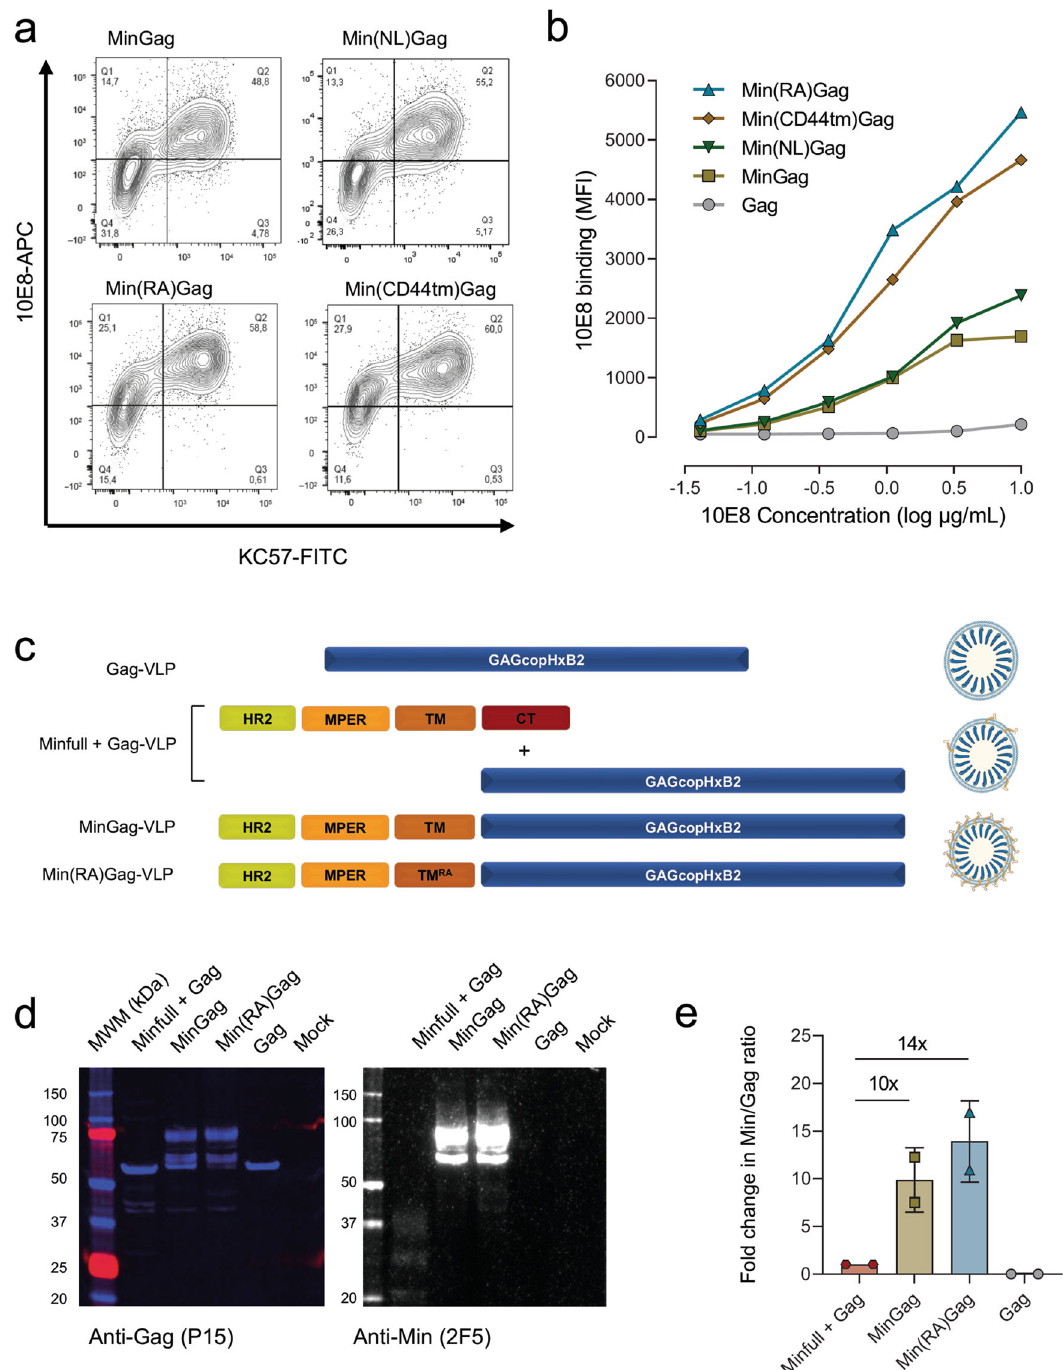
Fig. 2 Optimisation of Min antigenicity on the surface of VLP-producing Expi293F cells. a Dot plots of Expi293F cells transfected with mingag constructs bearing different transmembrane or linker variants: original (MinGag; same as shown in Fig. 1b) no linker (Min(NL)Gag), gp41 R696A mutation (Min(RA)Gag), CD44tm (Min(CD44)Gag). Cells were extracellularly stained with an anti-MPER antibody (10E8) and intracellularly stained with an anti-p24 antibody (KC57-FITC). b Dose-response curves of 10E8-binding to Min on the surface of Expi293F cells transfected with transmembrane and linker mingag variants. c Schematic representation of the strategies used to produce Gag-VLPs, low- density Minfull + Gag-VLPs or high-density MinGag- and Min(RA)Gag-VLPs. d Western Blot analysis of the same gel loaded with VLPs puri fi ed from supernatant of Expi293 cells transfected with Minfull + Gag, MinGag or Min(RA)Gag. Left panel: anti-p15 antibody. Right panel: 2F5 antibody (anti-MPER). Uncropped images are displayed at Supplementary Fig. 2b. e Quanti fi cation of Min/Gag ratios from the Western Blot as a measure of Min incorporation into VLPs. Data represented as mean ± SD, and values indicate fold